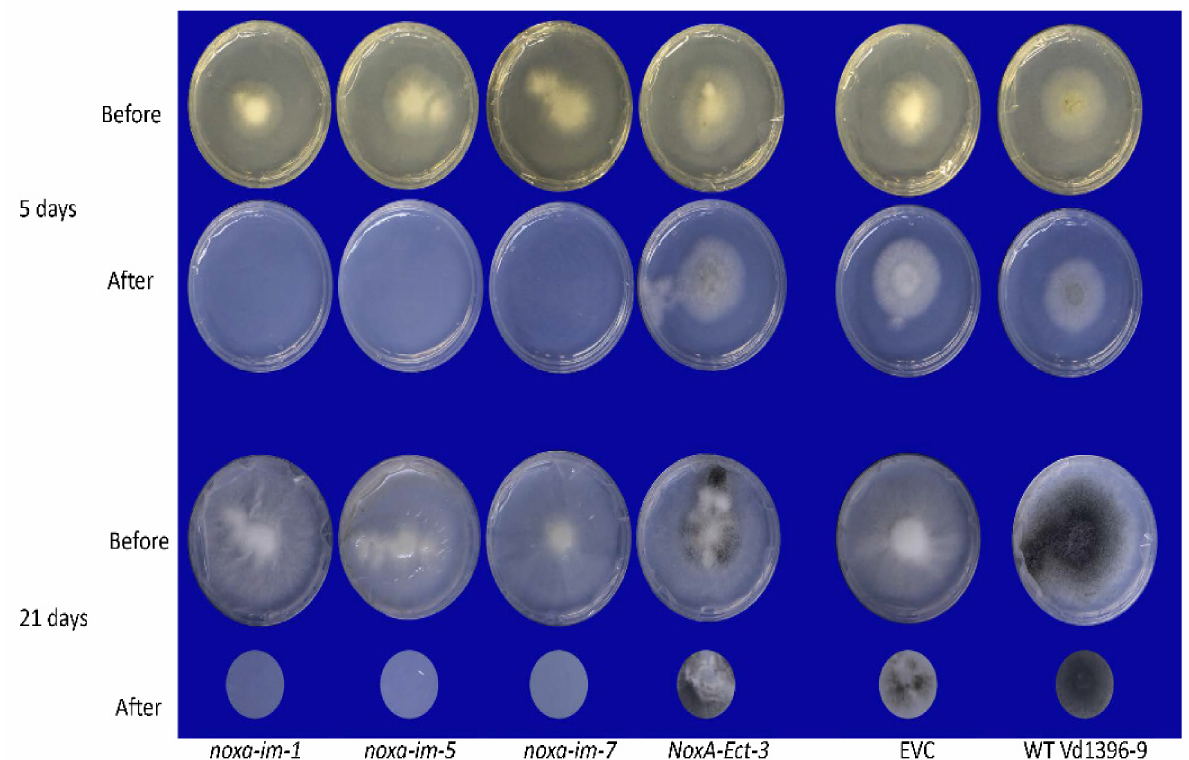
Figure 7. The penetration ability test of noxa mutants on cellophane membrane. Each isolate was repeated six times. All isolates were firstly inoculated on solid CDB media covered with a cellophane membrane for five and 21 days (indicated as Before) at 23 ± 1 ◦ C, following which the cellophane membranes were removed from the media and maintained under the same conditions for an additional four days (indicated as After). In almost all cases, both wild type and mutant strains could reach the edge of the plates after 21 days of incubation. This does not confirm the penetration ability, but the middle of the plates would only allow those isolates with full penetration ability to grow, as only mycelia with penetration ability can pass through the cellophane sheet from the plate’s center. Therefore, to reduce the confusion, here we only show the middle of the plates after 21 days of incubation.